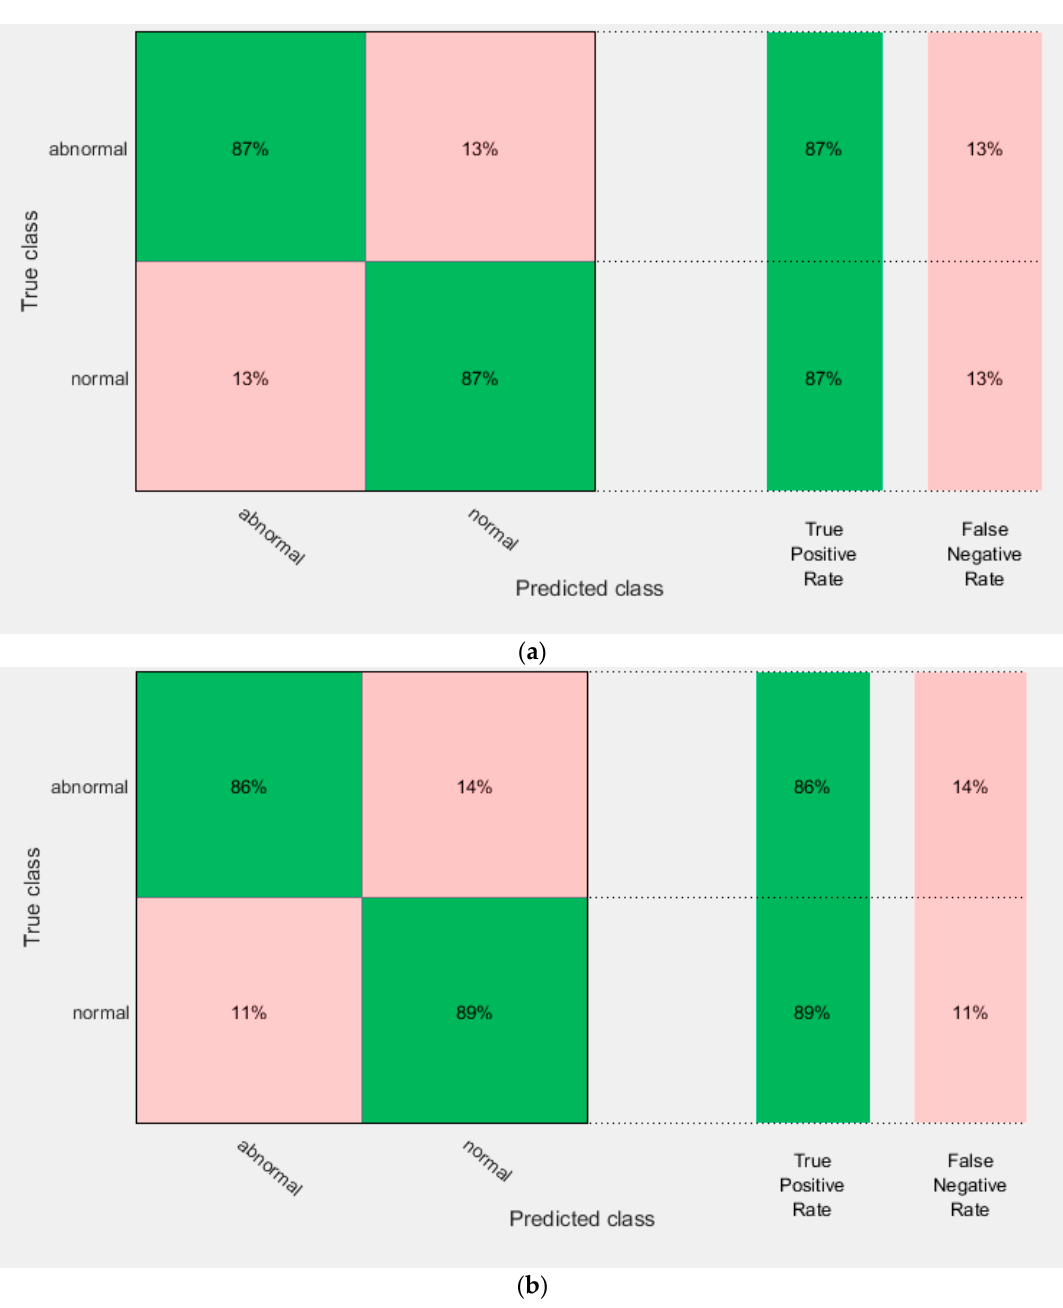
Figure 9. The confusion matrix of AlexNet + ResNet 50 fused features using ( a ) the linear SVM, and ( b ) the quadratic SVM.